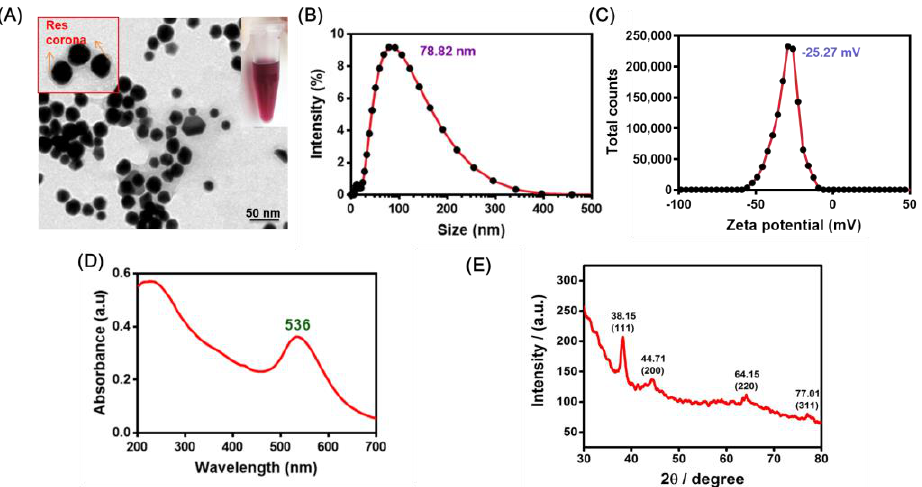
Figure 1. The characterization of gold nanoparticles containing resveratrol (RGNPs). ( A ) Transmission Electron Microscope (TEM) image of RGNPs. ( B ) The hydrodynamic size distribution of RGNPs. ( C ) The zeta potential of RGNPs. ( D ) UV–vis spectrum of RGNPs. ( E ) X-ray diffraction (XRD) pattern determining the crystalline nature of RGNPs.